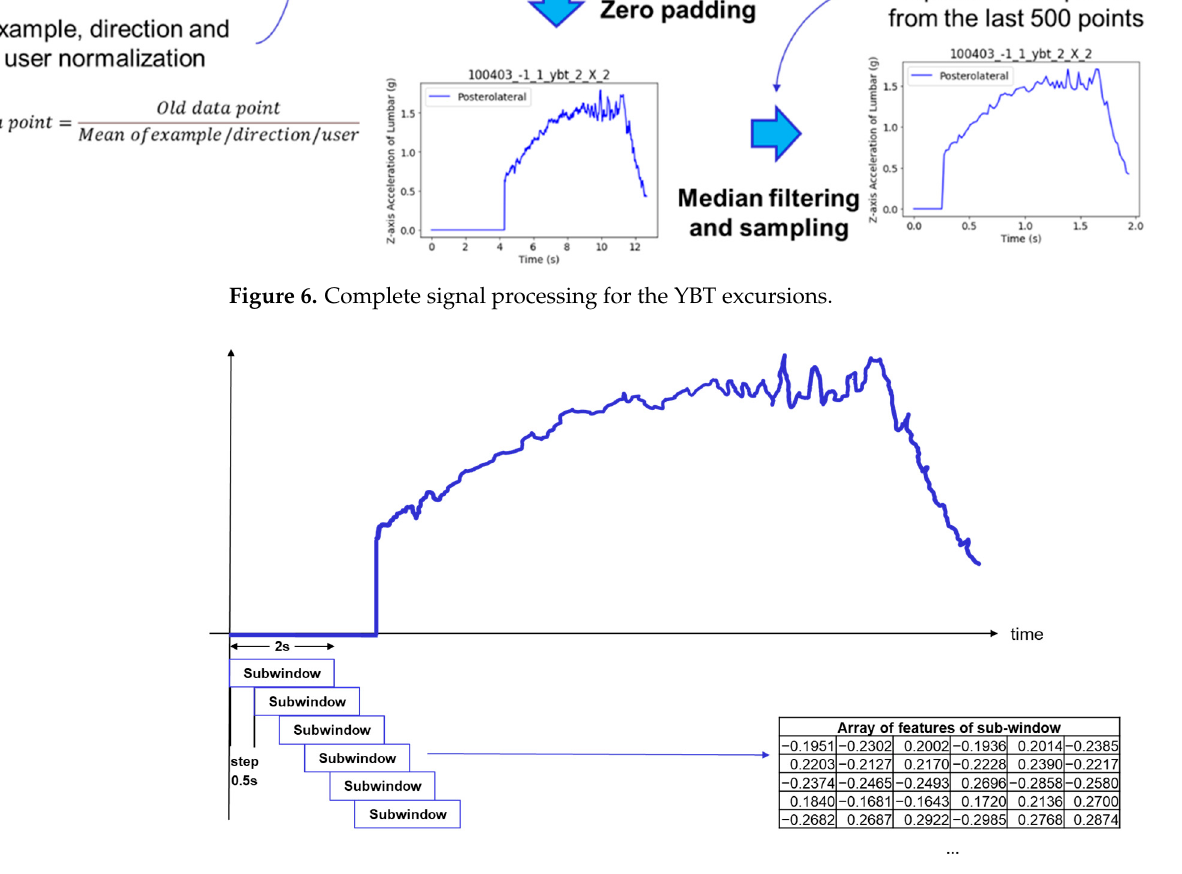
Figure 6. Complete signal processing for the YBT excursions.